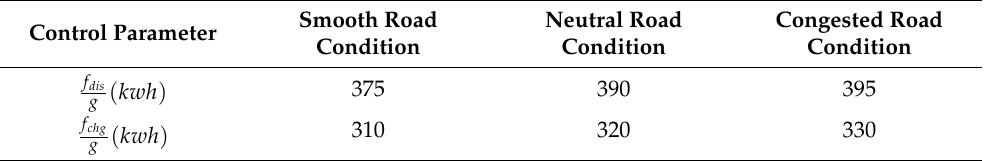
Table 1. Equivalent factor selection under different working